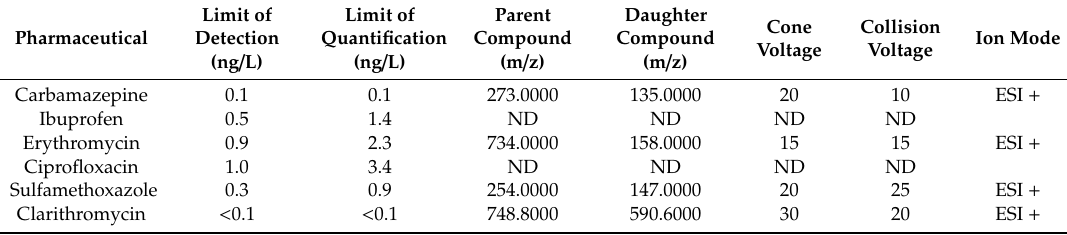
Table 3. The analytical parameters for the ultra-performance liquid chromatography coupled with